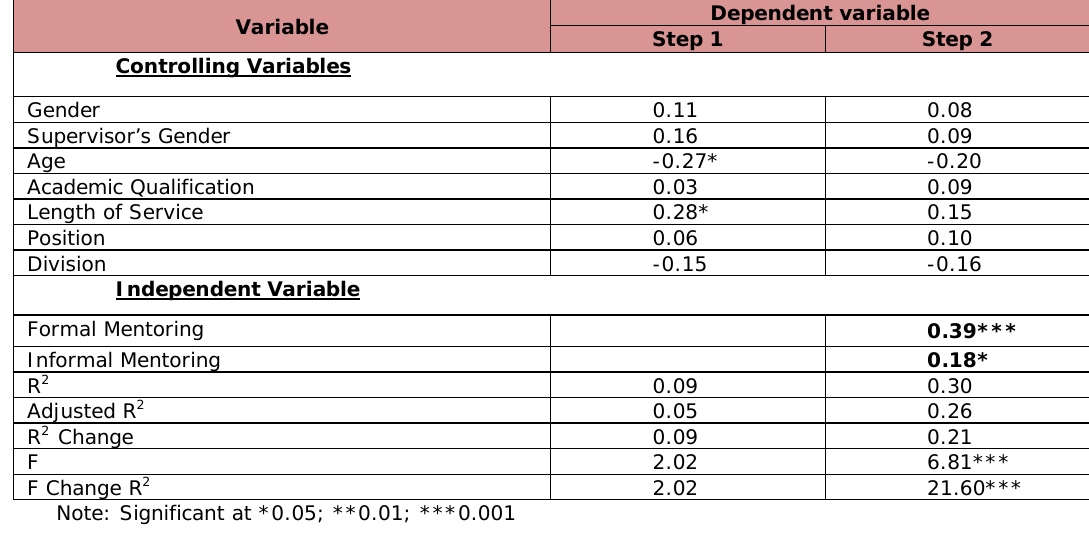
Table 5. “Result for stepwise regression analysis for psychosocial support as dependent variable”. Source: